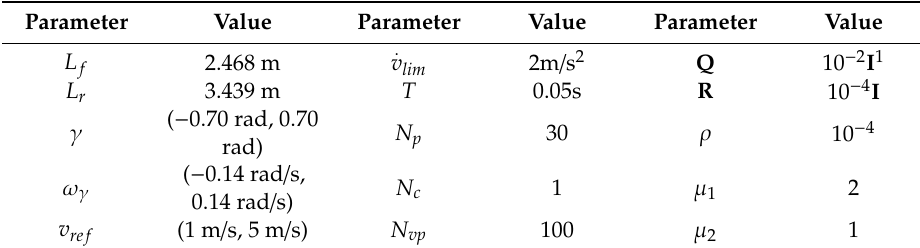
Table 1. Parameter